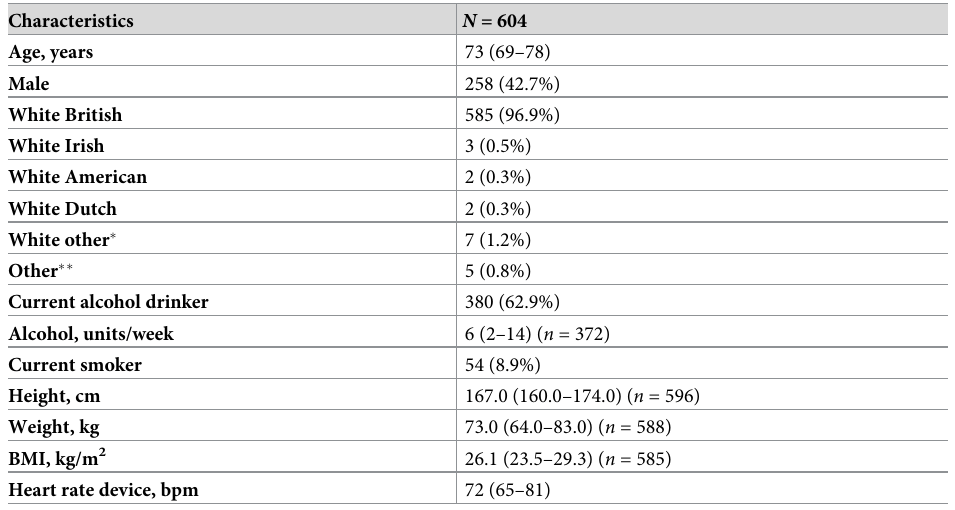
Table 1. A summary of participant demographic characteristics ( n =